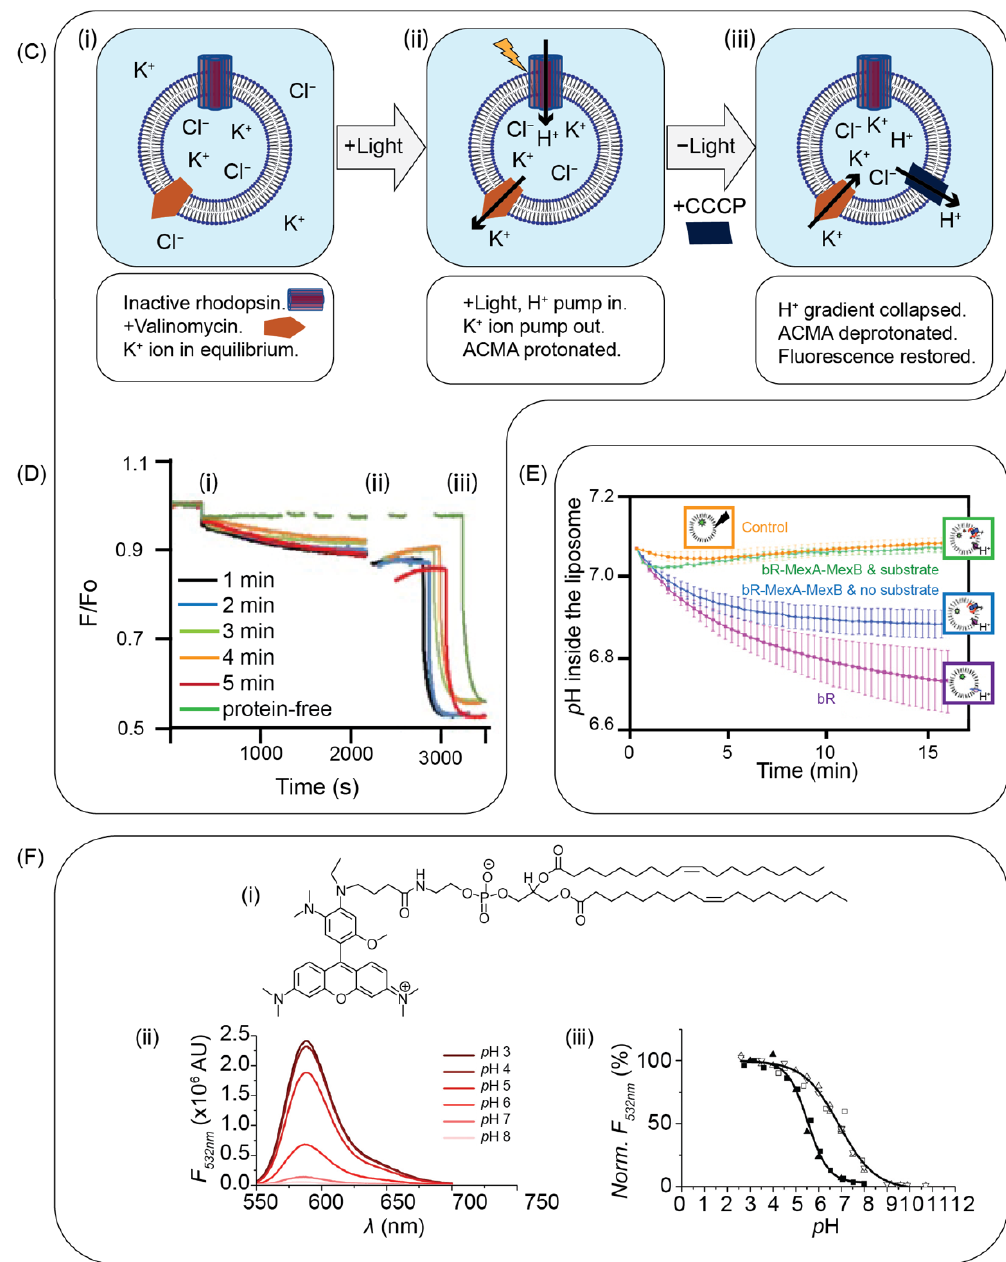
Figure 4. Fluorescence-based assays for characterizing ion channels. ( A ) Light–dark cycle of the photoactivity of rhodopsin—rhodopsin pumps protons as a result of light activation. In the dark, protons equilibrate by passive diffusion inside and outside of the liposome. Upon illumination again, rhodopsin activates, and proton flow recommences from outside of the proteoliposome. ( B ) Types of p H-sensitive dyes used to monitor proton flow: (1) hydrophobic membrane-permeable fluorescent dye, (2) water soluble membrane impermeable dyes, and (3) lipids with a p H-sensitive head group. ( C ) Schematic of the ACMA-based rhodopsin photoactivity assay: (i) in the proteoliposome mixture, ACMA, high concentration KCl, and valinomycin are added; (ii) upon illumination, rhodopsin-mediated proton pumping occurs pumping protons into the liposome which causes protonation and quenching of ACMA; efflux of K + compensates for the charge imbalance arising from proton flow into the liposome; and (iii) finally, the addition of CCCP allows the free diffusion of protons across the membrane and thus the fluorescence intensity of ACMA drops rapidly. ( D ) Time-lapse recording of the fluorescence intensity relative to the initial fluorescence (F O ), where “min” in the legend corresponds to the time in minutes. The numbering (i), (ii), and (iii) corresponds to the events described in Figure 4C. Reprinted with permission from ref.